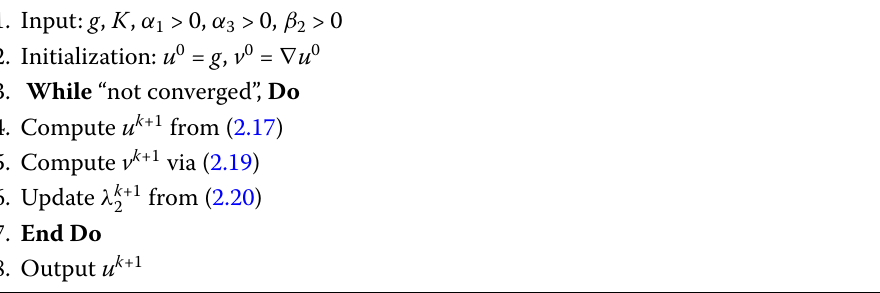
Algorithm 2 Alternating direction minimization method for solving the subproblem